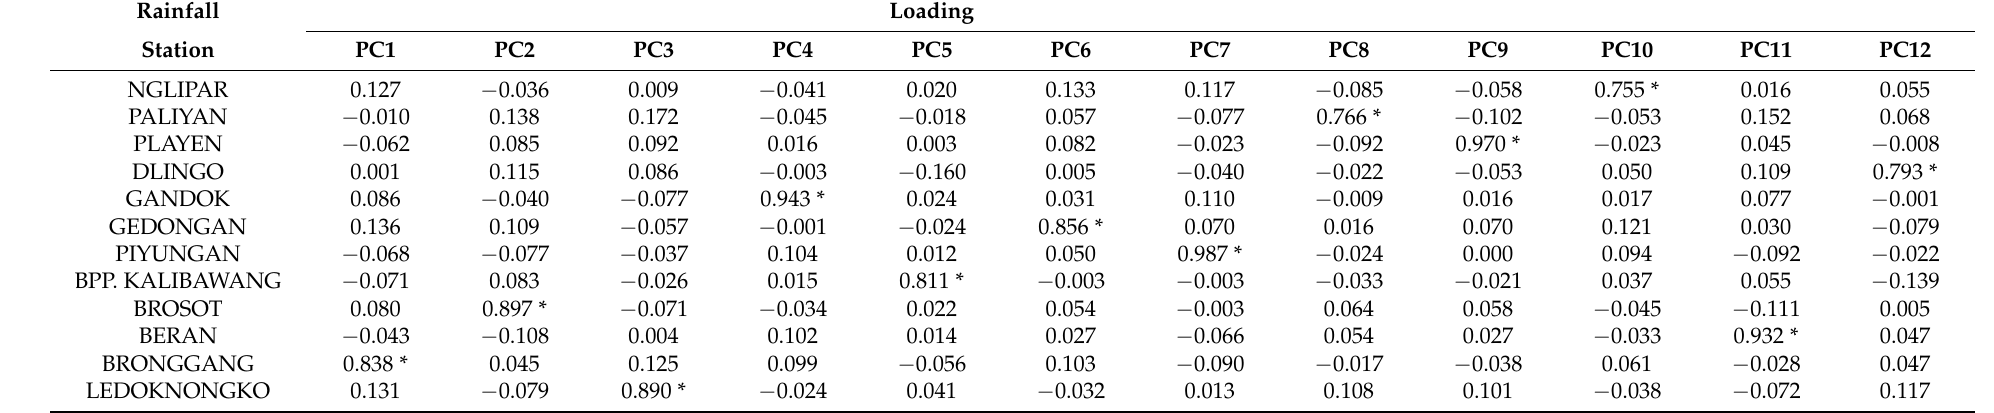
Table 7. Loadings for the first 12 PCs of the inter-monsoon season in Yogyakarta,